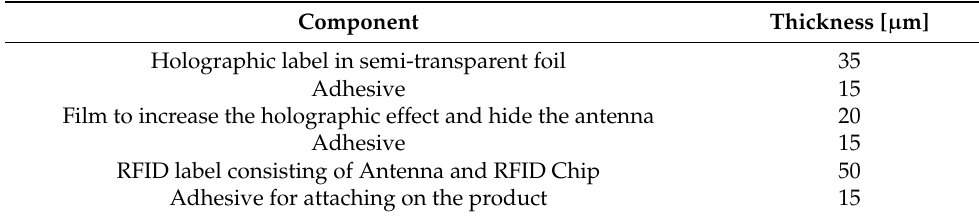
Table 2. Component thicknesses of the multi-layer smart holographic label.